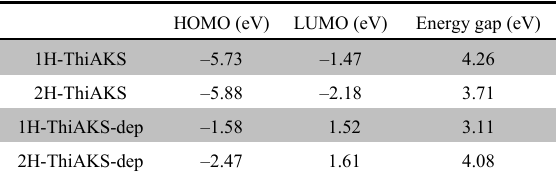
Fig. 6 HOMO-LUMO images of ThiAKS Green. Table 1 Homo and Lumo levels of the probe.